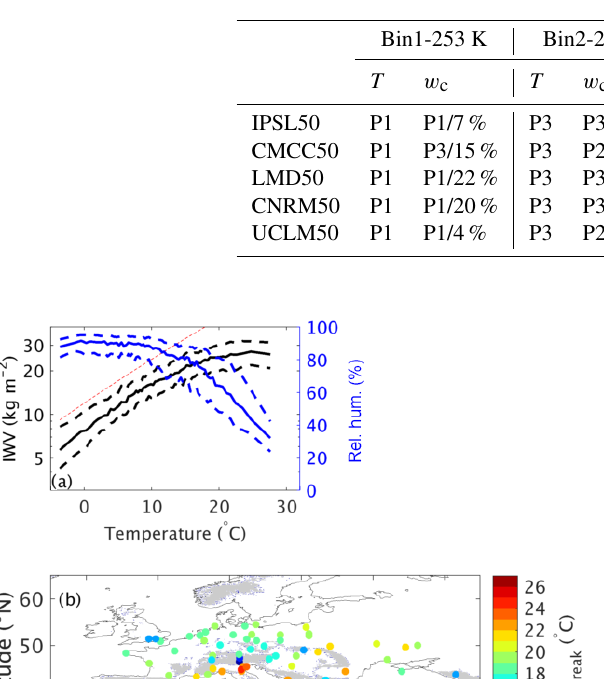
Table 7. Period for which the maximum value of the temperature bin ( T ) and the critical value of IWV ( w c ) is reached. Period 1 is for 1989– 1996, P2 for 1995–2002 and P3 for 2001–2008. The second number in the column of w c corresponds to the maximum relative variability of